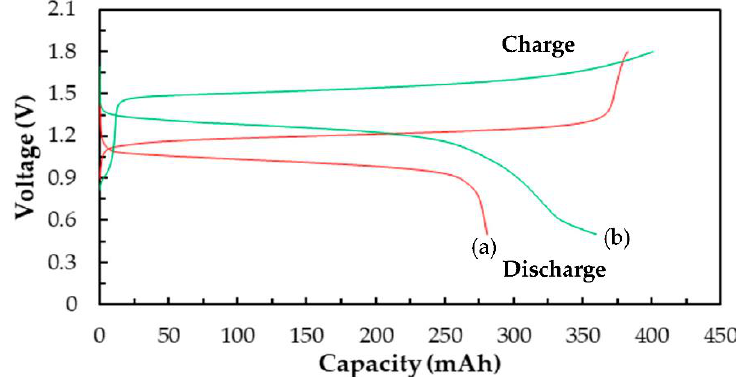
Figure 9. The charge and discharge capacity curves of the third cycle of the Ce/ascorbic acid/I RFB system with different separation membranes: ( a ) N-117, ( b ) N-117 – SiO 2 – SO 3 H.